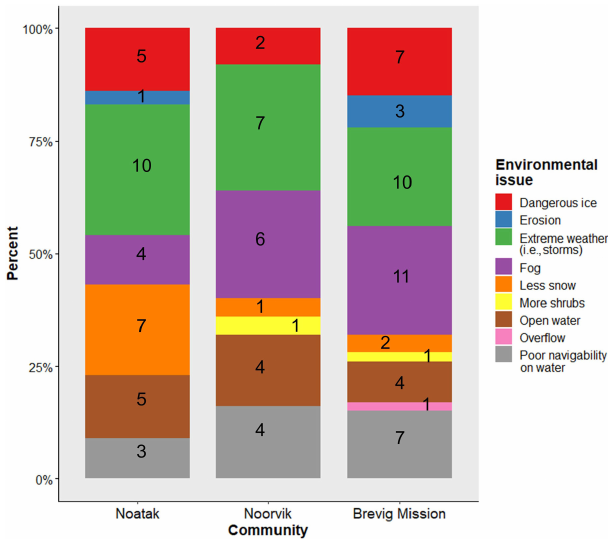
Fig. 2 . Environmental conditions for which interviewees